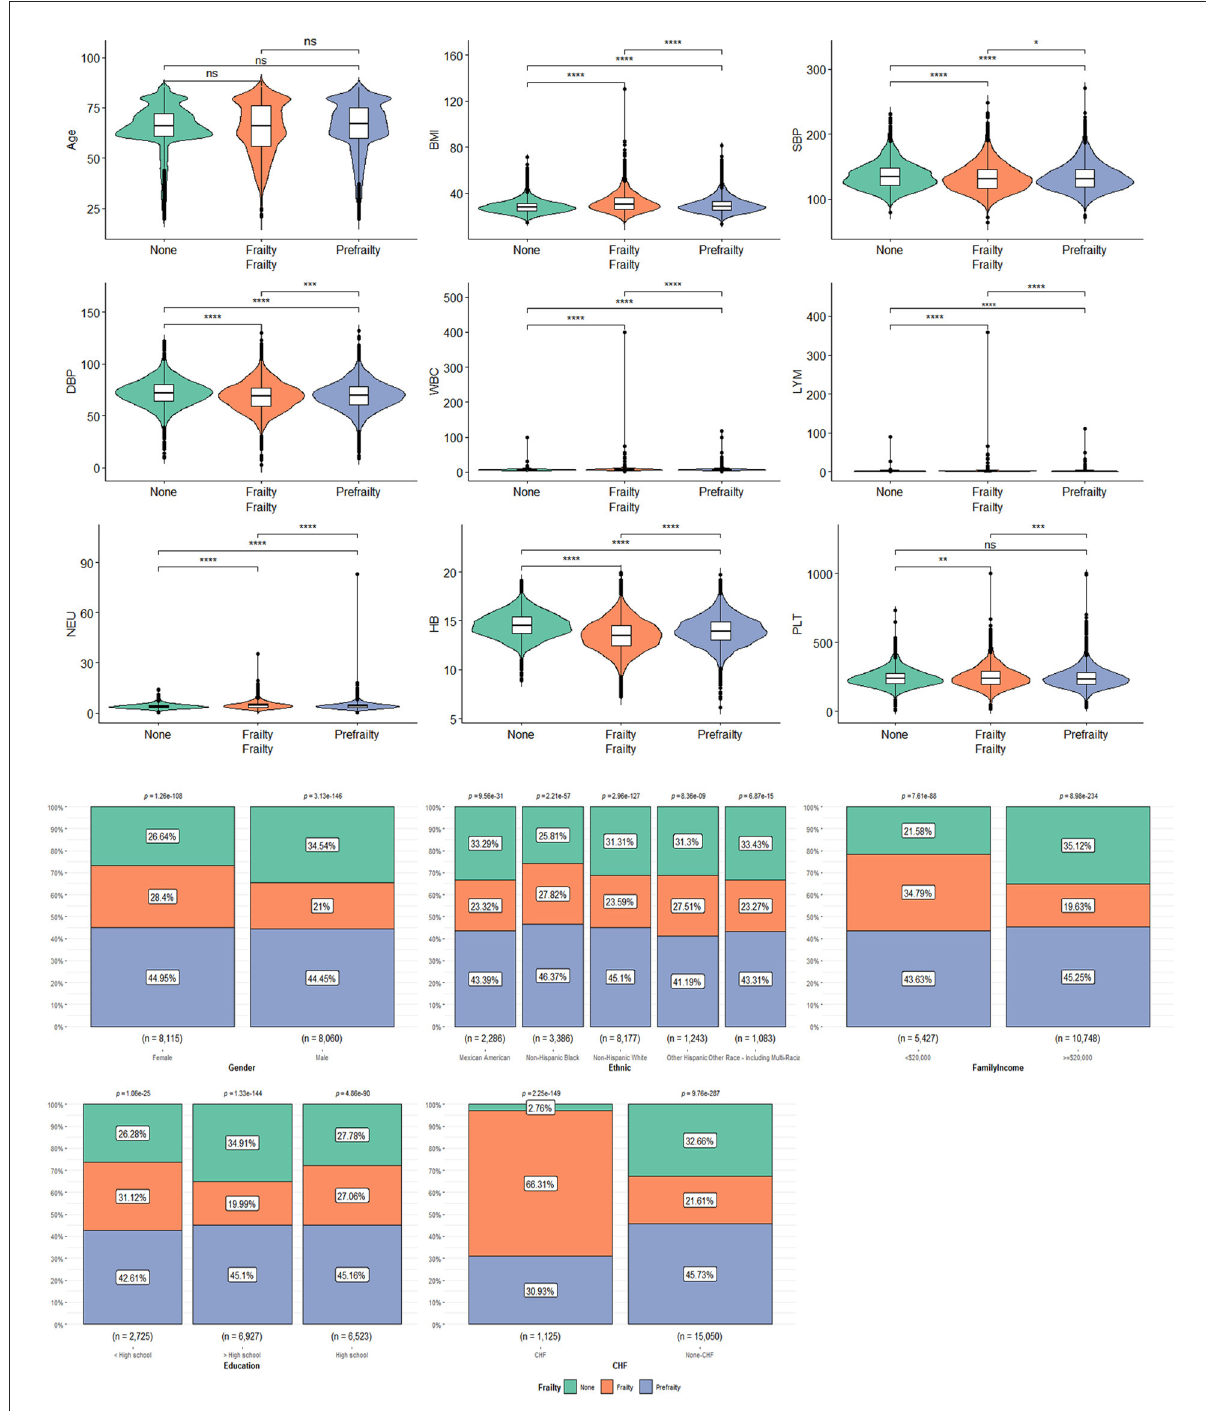
FIGURE3 The characteristics of participants with frailty, pre-frailty, and non-frailty: *means P < 0.05; **means P < 0.01; ***means P < 0.001; ****means P <